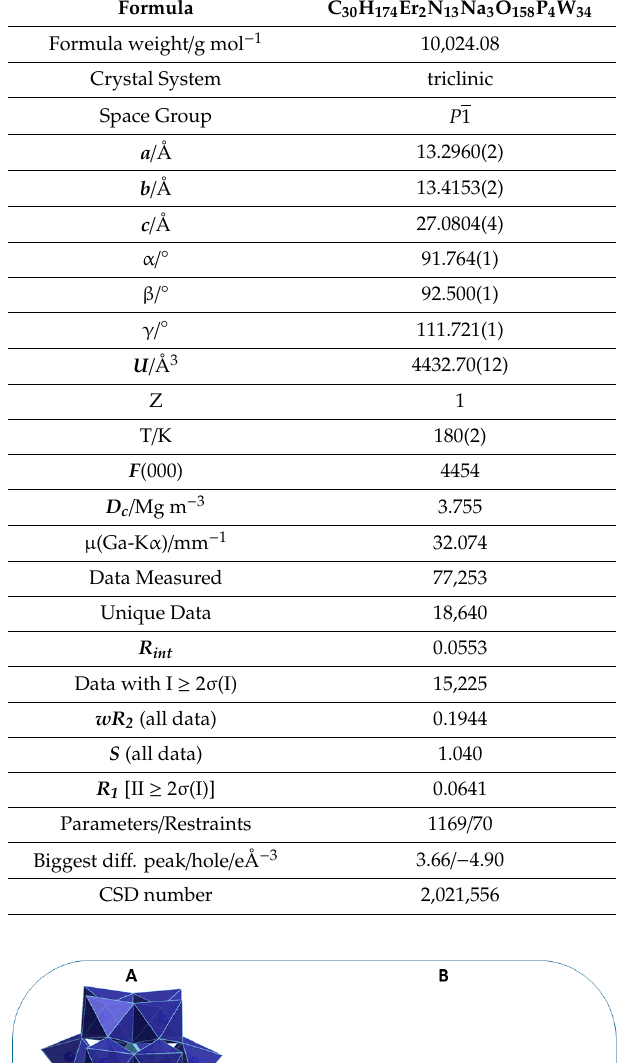
Table 1. Crystallographic data for 1 .